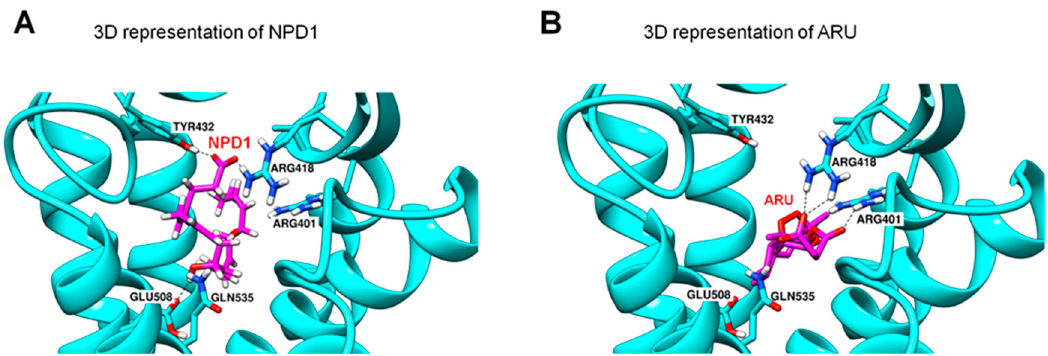
Figure 3. 3D representation of NPD1 ( A ) and ARU ( B ) interactions with GPR37 . The docking results show postulated GPR37 binding sites for NPD1 and the antimalaria drug artesunate (ARU). NPD1